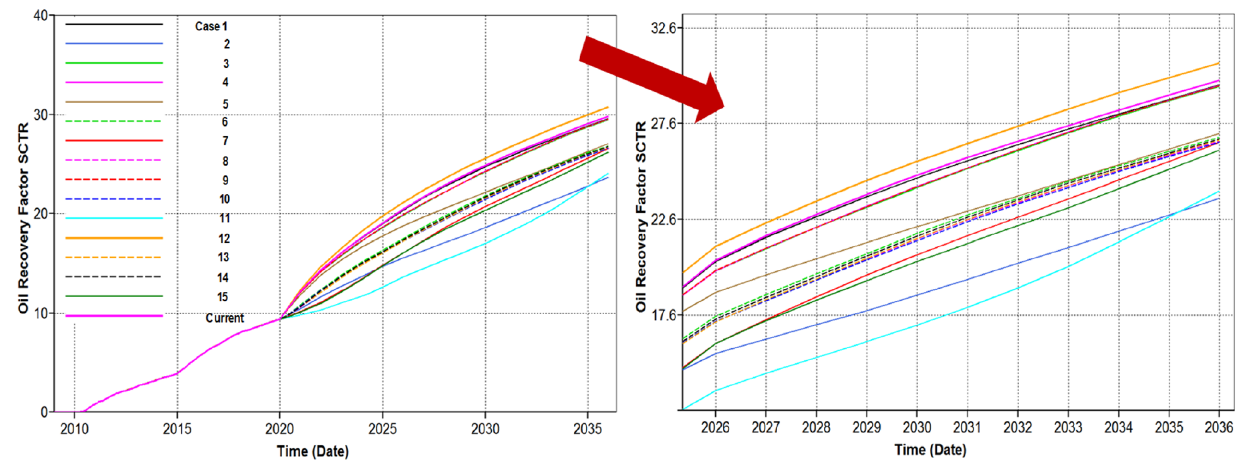
Fig. 15 Recovery factor curve of each case